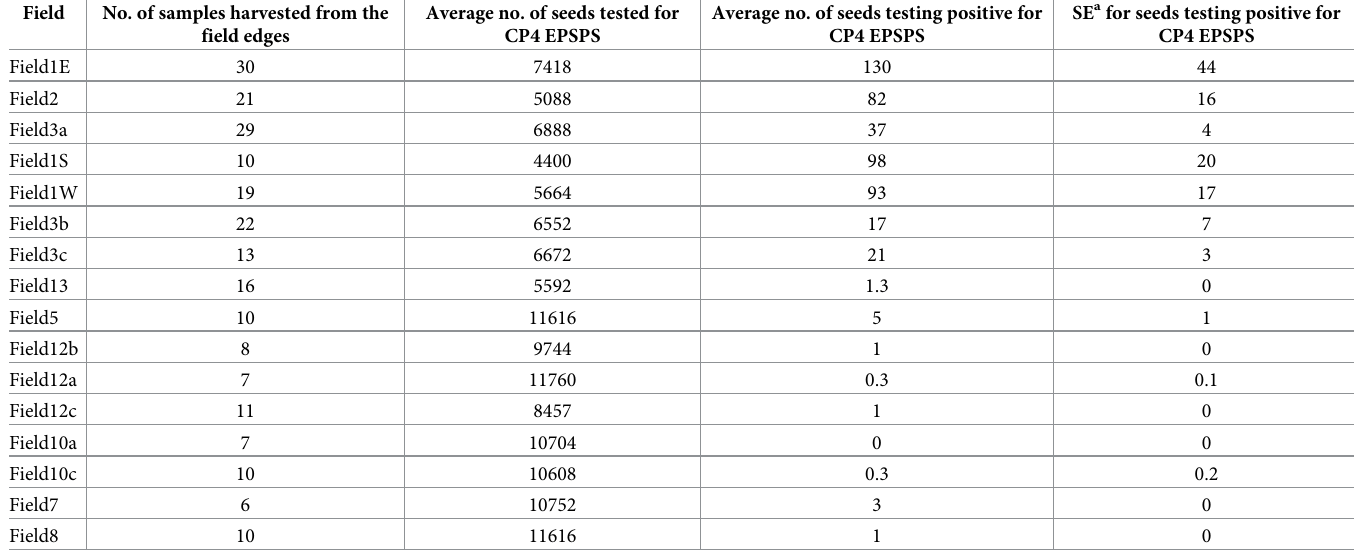
Table 3. Average number of seeds tested and average number of seeds testing positive for the glyphosate resistance gene in samples harvested from the edges of the